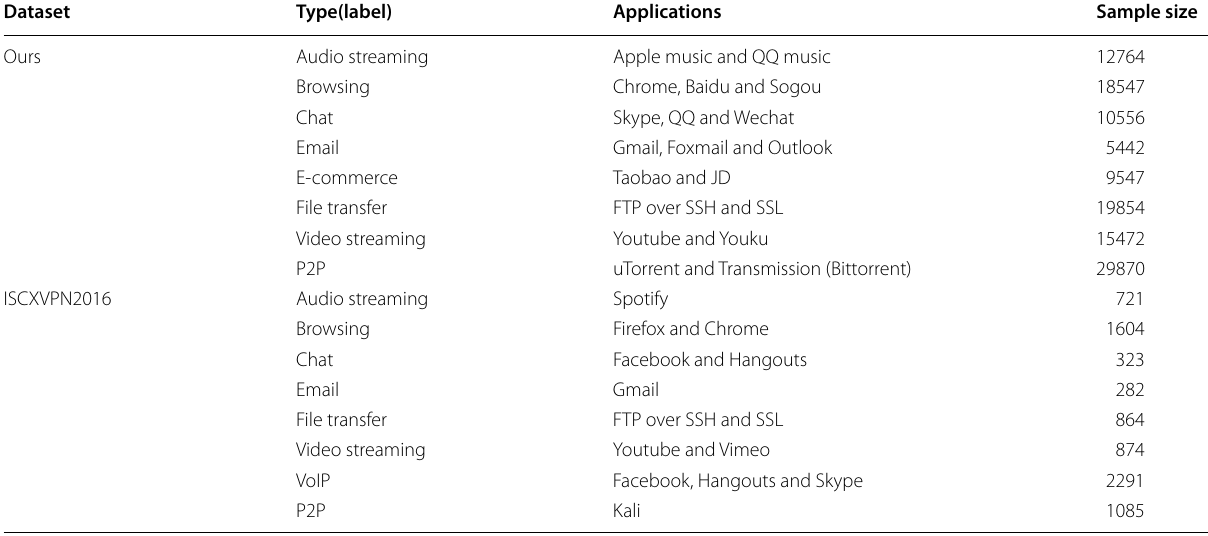
Table 1 Description of the dataset Dataset